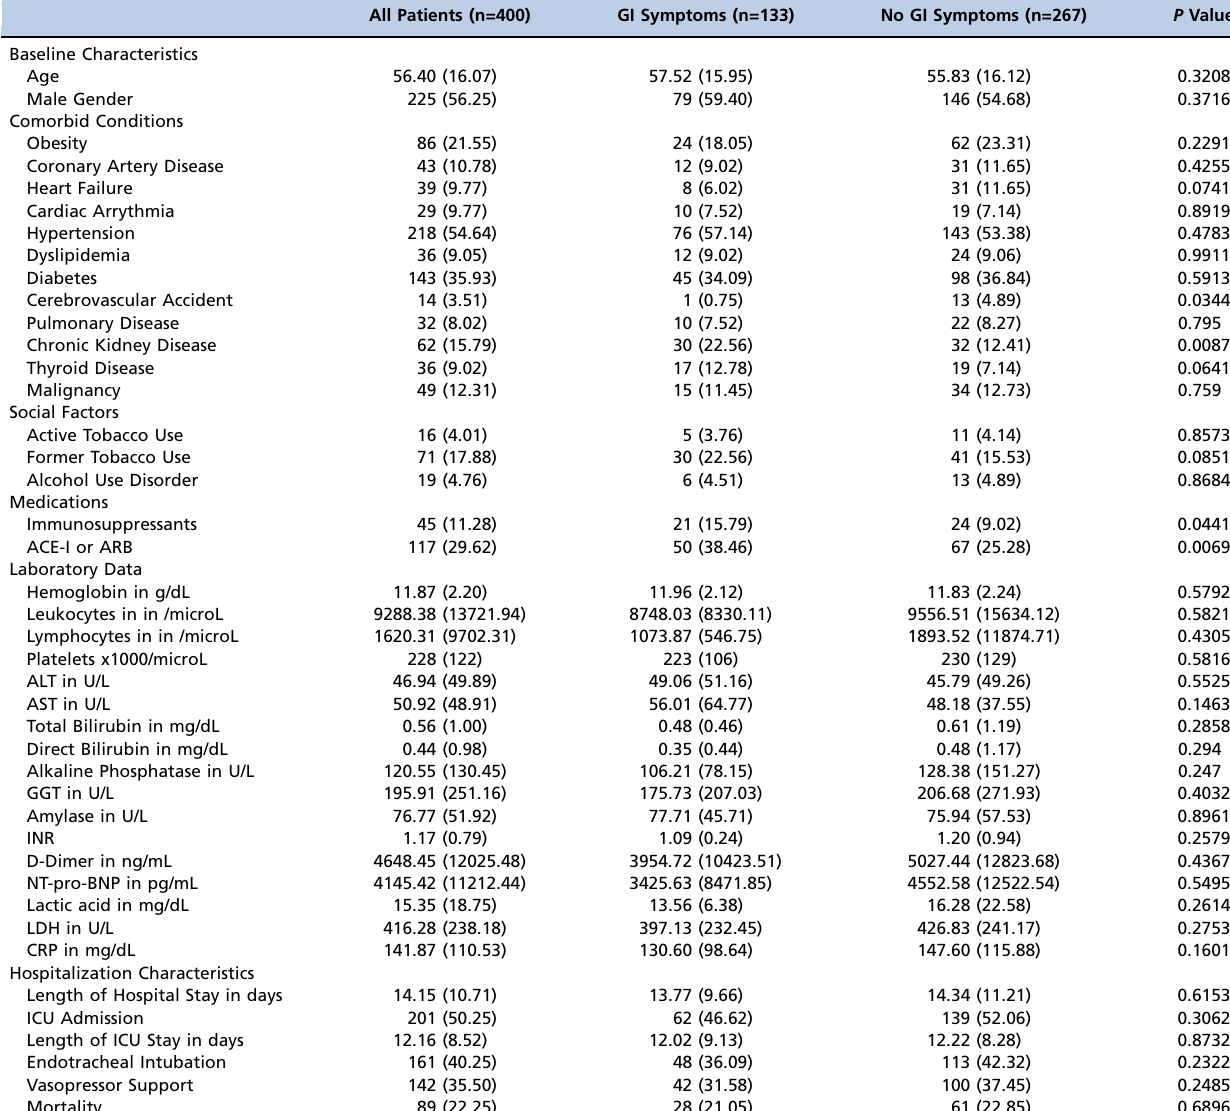
Table 1 - Baseline Clinical Characteristics, Comorbidities, Social Factors, Medications, and Laboratory Data on Admission, and Outcomes of COVID-19 Hospitalizations.